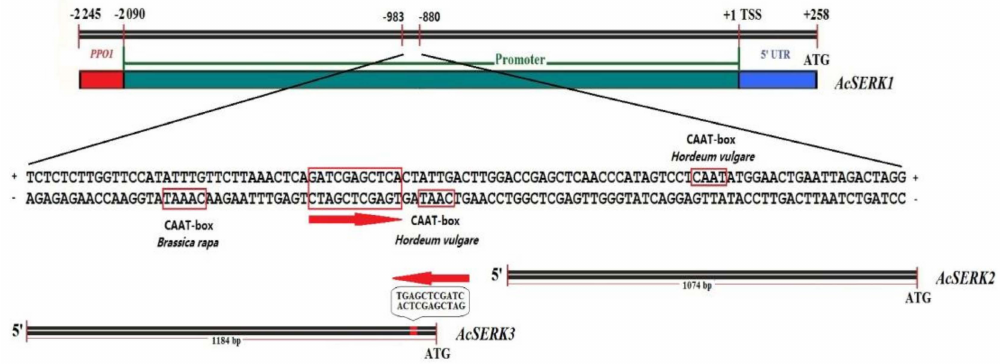
Figure 4. Bioinformatics analysis of embryonic cell-specific